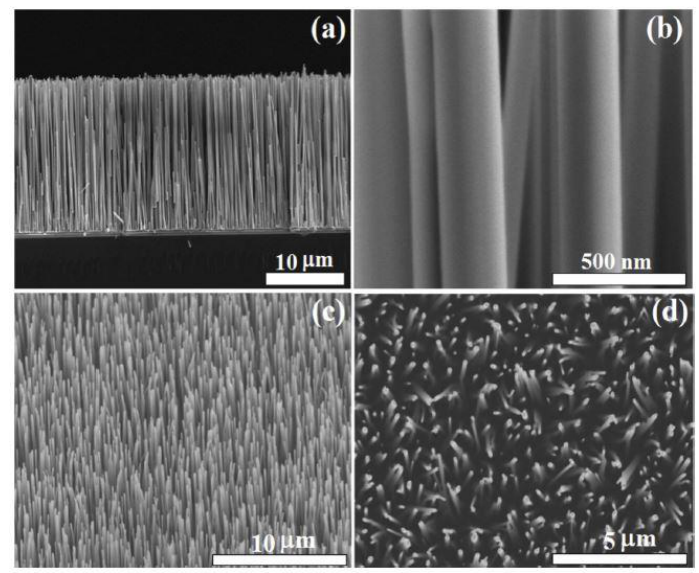
Figure 3. Field scanning electron microscope (FESEM), cross-section of ZnO-Nanoroads (NRs) ( a ), closer cross-sectional view of ZnO-NRs ( b ), 25 ° lateral ( c ) and top view of ZnO-NRs [122] ( d ). Reproduced (2020) with permission from Elsevier.